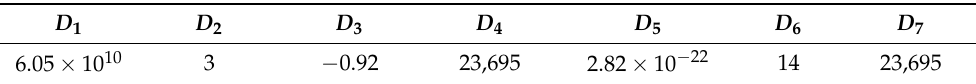
Table 1. Material parameters for combined time hardening equation, where temperature is expressed in K, time in s, and stress in MPa